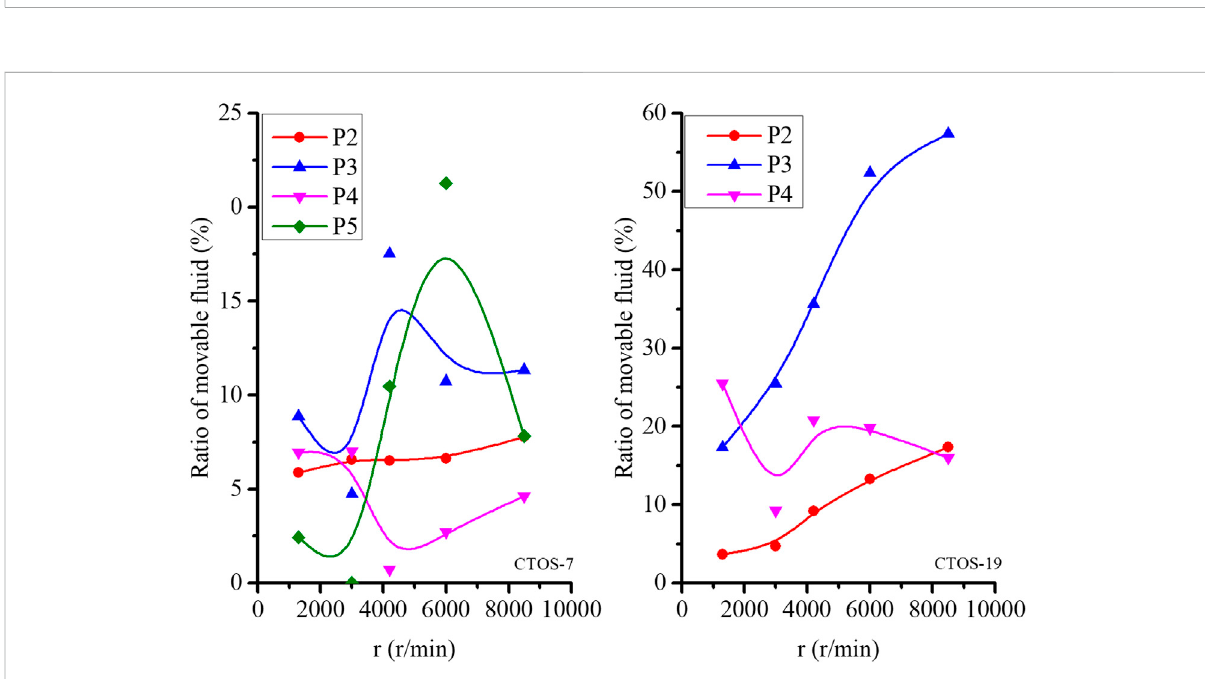
FIGURE 10 The difference mobility of fl uids in various pores of CTOS-7 and CTOS-19